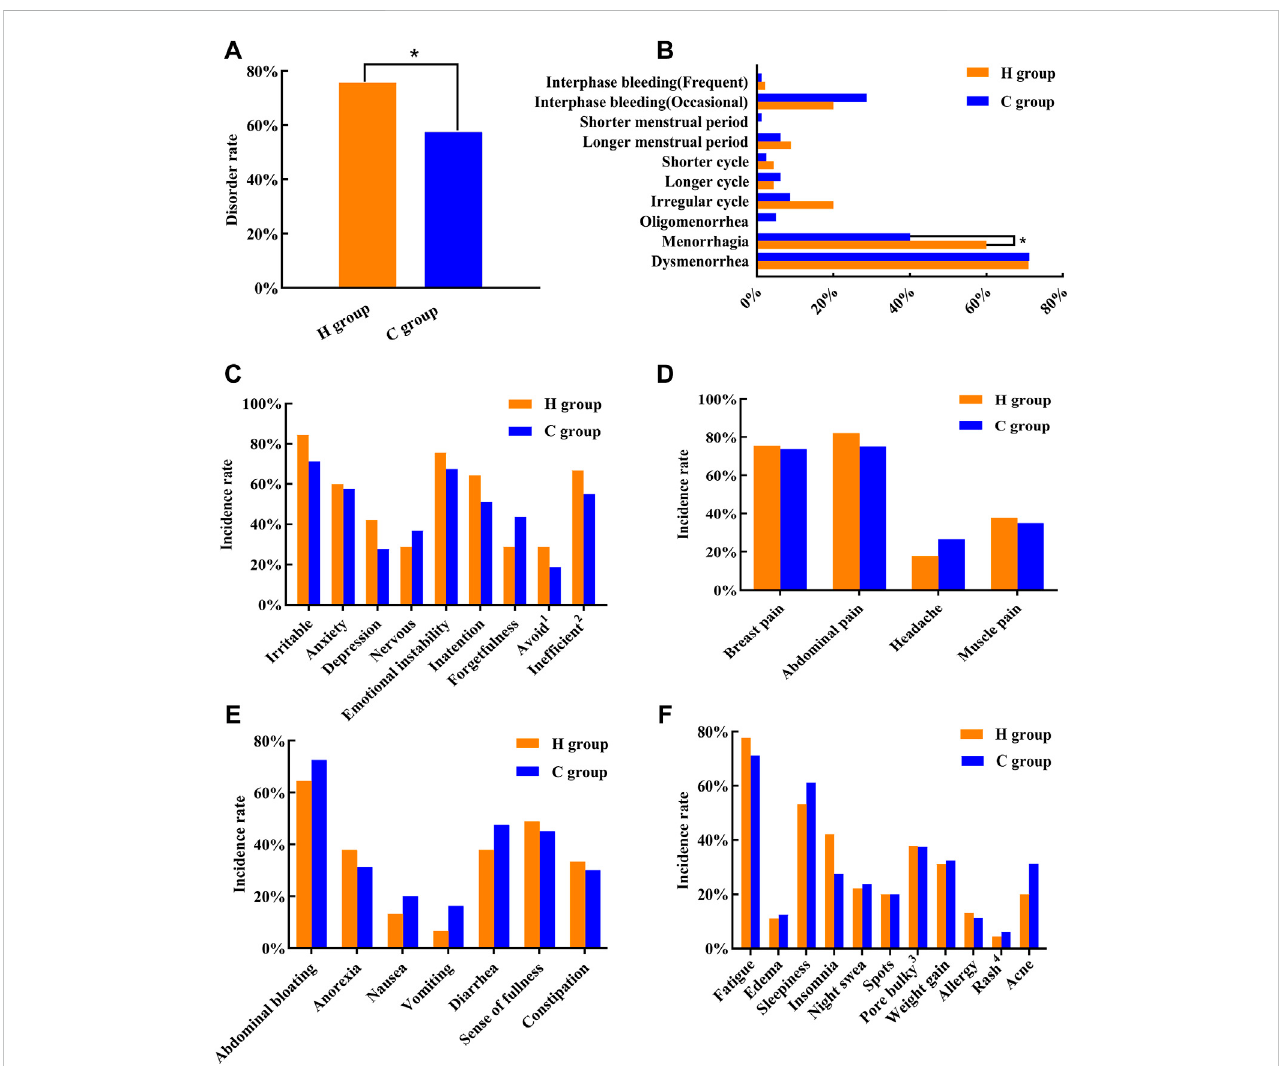
FIGURE 1 Menstrual disorder status in the two groups of women. (A) Menstrual disorder rate. (B) Menstrual disorder characteristics. (C) Premenstrual symptoms “ moodandsocialfunctioning. ” (D) Premenstrualsymptoms “ physicalpain. ” (E) Premenstrualsymptoms “ endocrine. ” (F) Premenstrualsymptoms “ others. ” * p < 0.05,whencomparedwiththeCgroup.1 “ Avoid ” :apersonmayshowsomelonelinessandreluctancetomeetpeopleduringtheweekbeforemenstruation.2 “ Inef fi cient ” : there is a tendency to do something as well as work less ef fi ciently. 3 “ Pore bulky ” : some women show enlarged pores on their faces during the premenstrual period. 4 “ Rash ” : the skin condition that some women experience as a rash on the face before